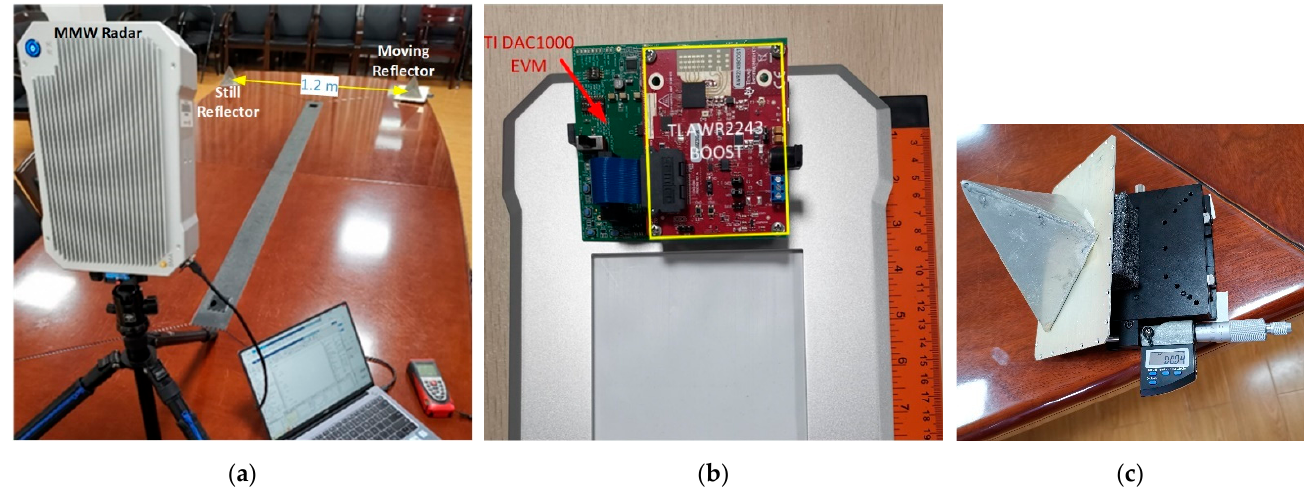
Figure 13. Multiple close targets displacement measuring experiment with an MMW MIMO radar. The radar is mounted on a tripod and connected to a laptop computer via a USB3.0 hub. ( a ) Two trihedral reflectors are placed at the end of a table. The left one is still and the right one can be moved on a sliding platform. The azimuth distance between them is 1.2 m; ( b ) the TI AWR2243BOOST is mounted on the TI DAC1000 EVM. ( c ) The right reflector is on the sliding platform which can be measured by a micrometer. The platform is stuck onto the desktop to suppress additional displacements caused by manual operations.